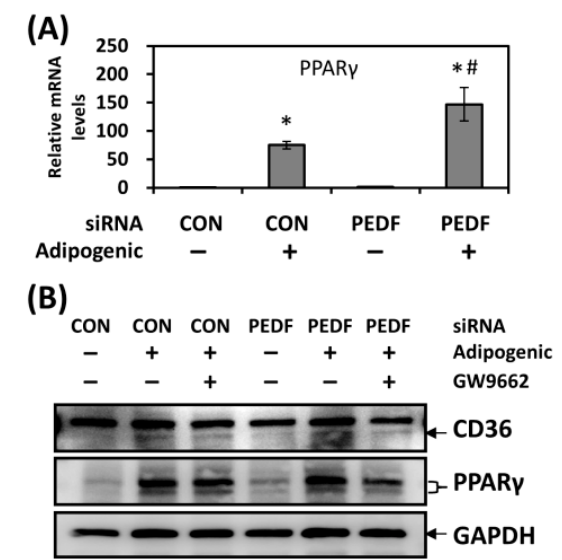
Figure 3. CD36 is negatively regulated by PEDF through PPAR γ during adipogenic differentiation. ( A ) PPAR γ expression was evaluated in differentiated rat AdSCs transfected with control or PEDF siRNA using quantitative RT-PCR. ( B ) CD36 and PPAR γ protein levels were determined in differentiated mouse 3T3-L1 cells transfected with control or PEDF siRNA, in the absence or presence of a PPAR γ inhibitor GW9662. * Statistically significant compared with the control transfected, vehicle-treated group at p < 0.05; # statistically significant compared with the PEDF siRNA transfected, vehicle-treated group at p < 0.05